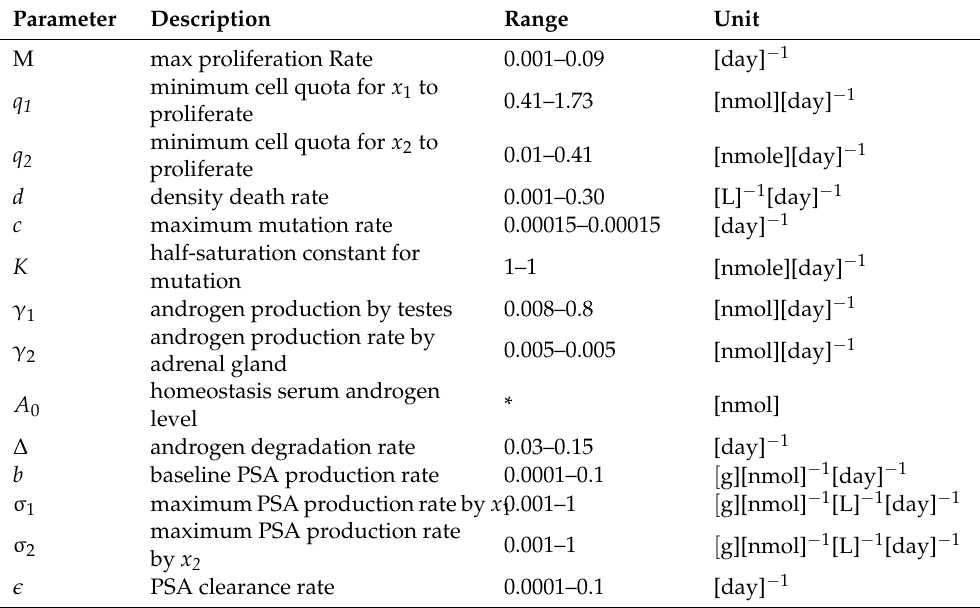
Table 1. Parameter definitions and boundaries: This table describes the physiological interpretations of the fifteen parameters used in this model [5,26]. The range column indicates the upper and lower bounds within which an error-minimizing function may establish an optimal value with respect to a concrete set of patient data. The * in place of upper and lower bounds of A 0 is because the range of A 0 is patient specific and is set to the patient’s maximum recorded androgen data ±